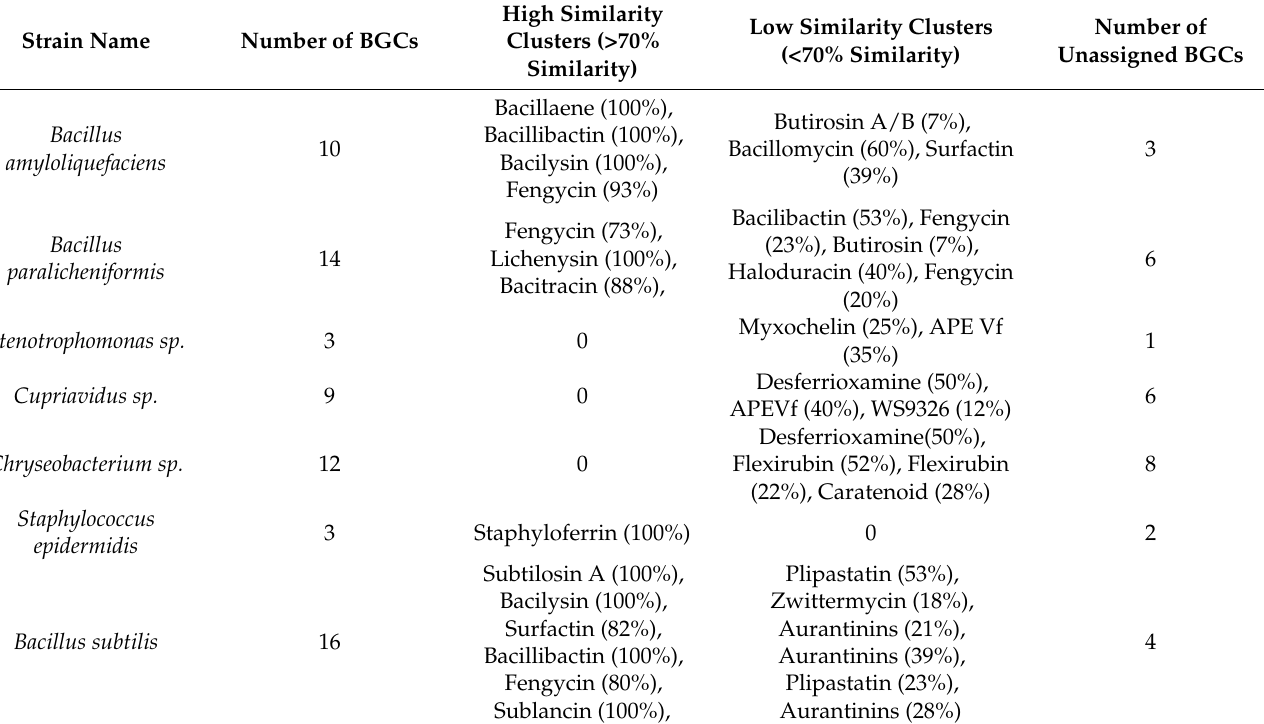
Table 3. Biosynthetic gene clusters identified by AntiSMASH server in the different bacterial